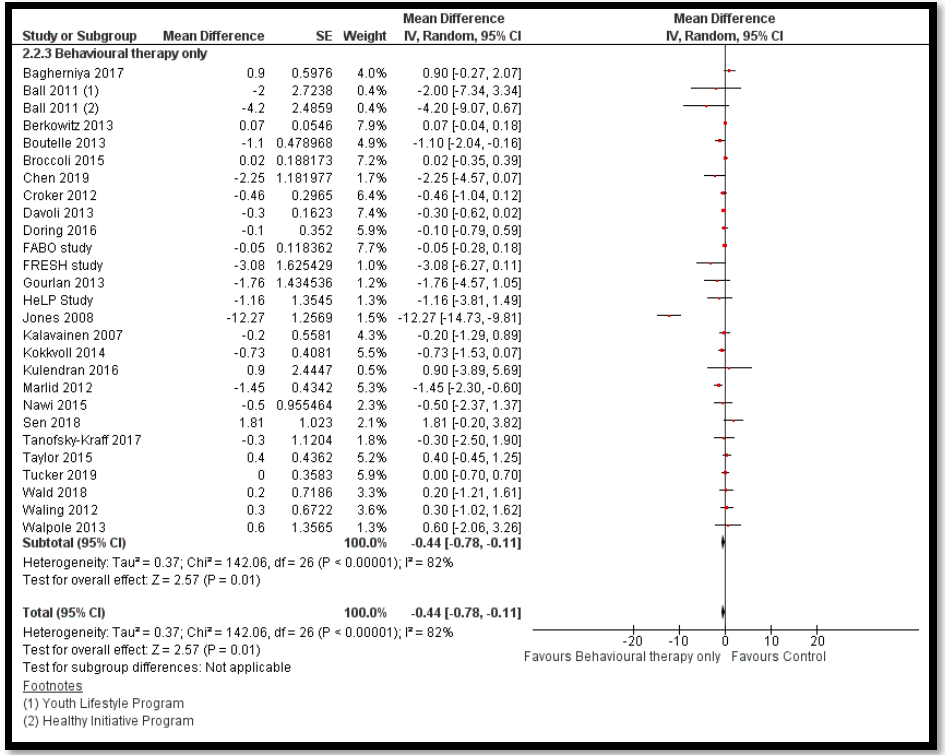
Figure 13. Forest plot for the effect of diet, exercise and behavioural therapy interventions for obesity management on body mass index (BMI) z -score .